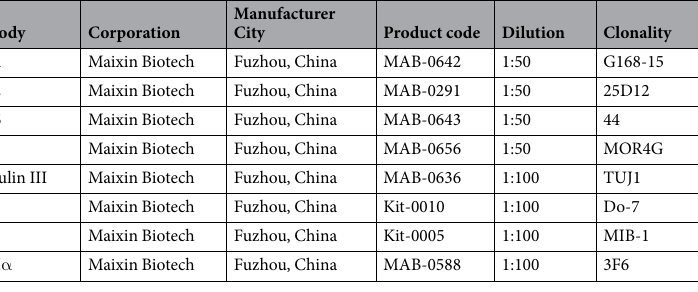
Table 1. The primary antibody of MLH1, MSH2, MSH6, PMS2, β -Tubulin III, P53, Ki67 and TOPII α used in this